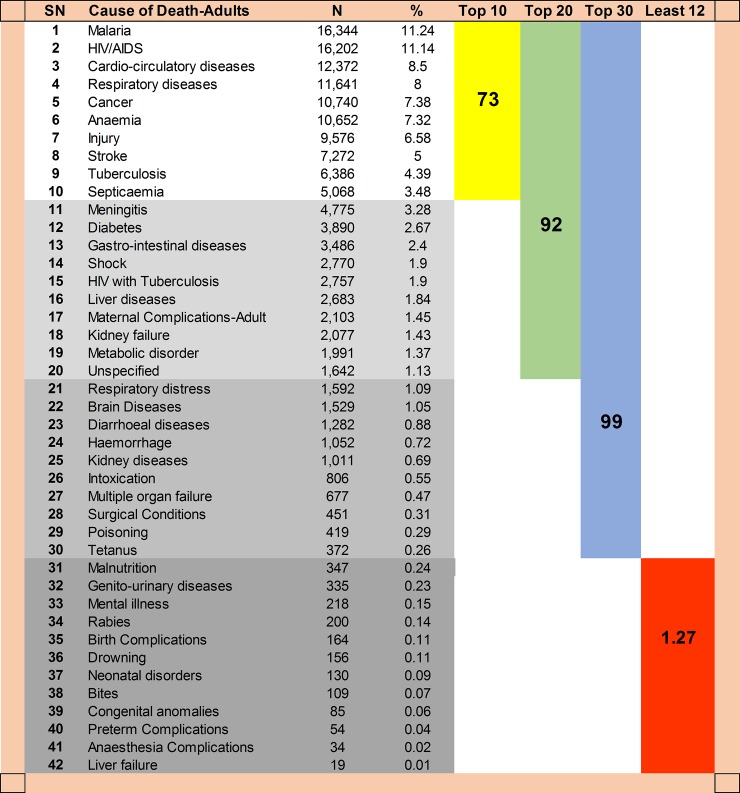
Cumulative proportion of death by cause of deaths groups among ≥ 5 years old.